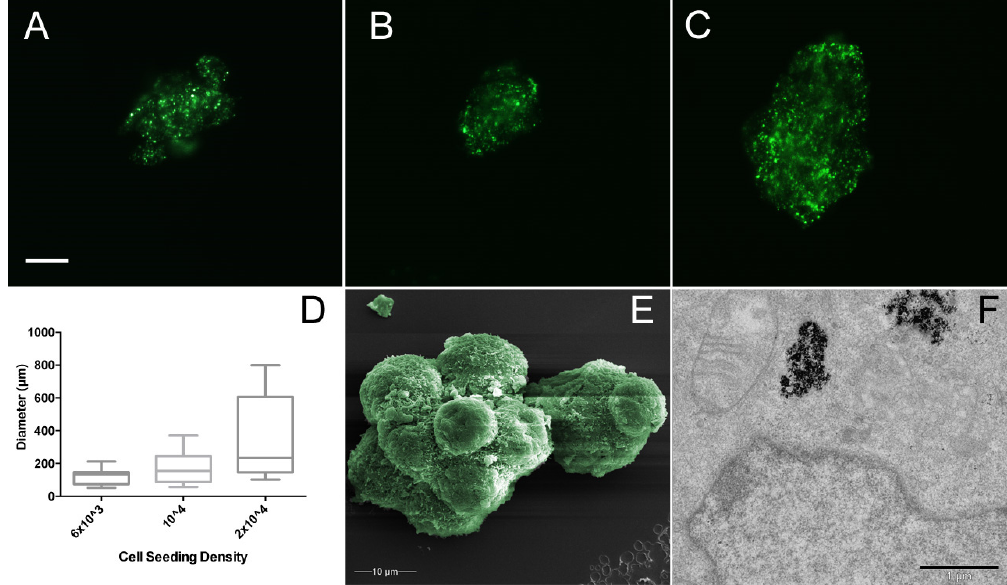
Figure 5. MSC spheroid area derived from cells seeded at ( A ) 6 × 10 3 , ( B ) 1 × 10 4 , and ( C ) 2 × 10 4 cells/mL. Note the increasing range of spheroid sizes with increased cell density. Scale bar = 10 μ m ( D ) Box and whisker plot of spheroid areas (spheroid n ≥ 15). ( E ) False colour scanning